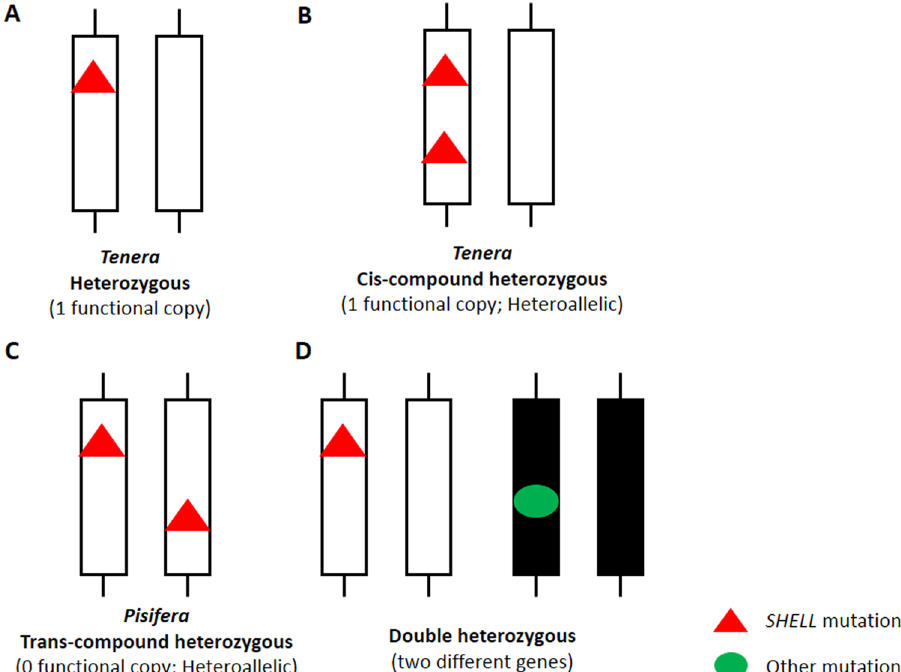
Figure 4. The zygosity of loss-of-function mutations in SHELL gene. ( A ) Tenera palm that carried a single heterozygous mutation, only produce 1 functional copy of the gene. ( B ) Cis-compound heterozygous tenera palms produce 1 functional copy, when both mutations occur on the same chromosome. ( C ) Trans-compound heterozygous pisifera palms produce 0 functional copy, when both mutations occur on different chromosome. ( D ) In double heterozygous individuals, the mutations occurred in different